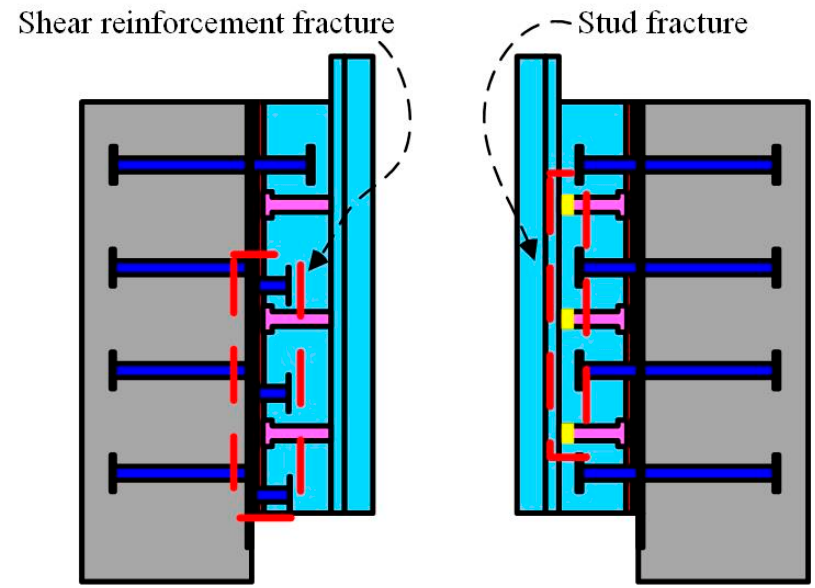
Figure 24. Two types of failure forms.